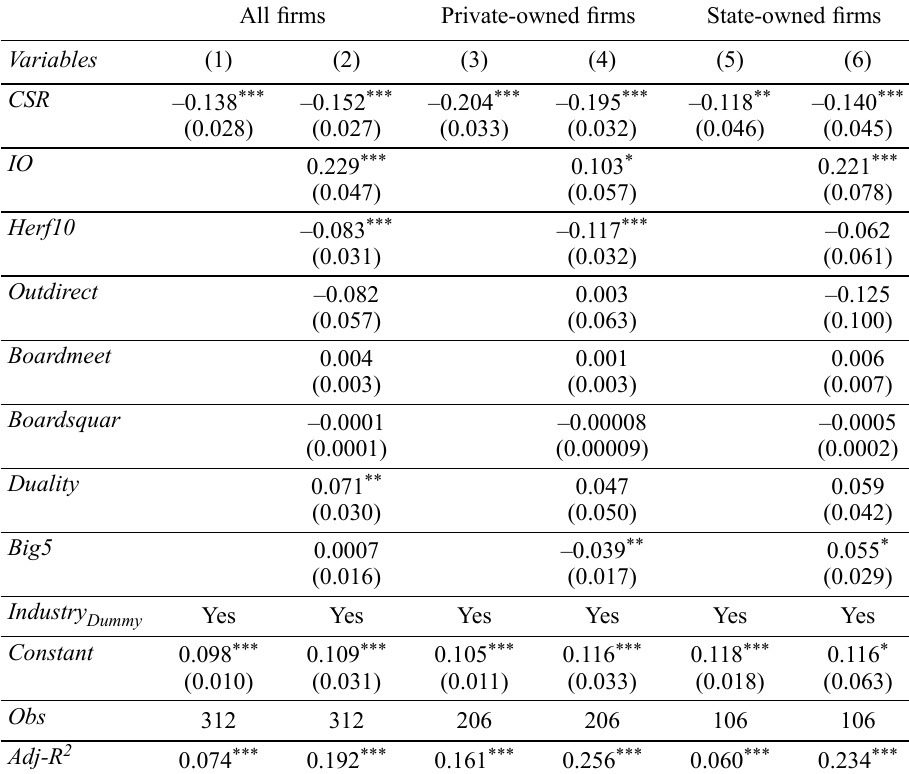
Table 3. The role of CSR in the minority shareholder